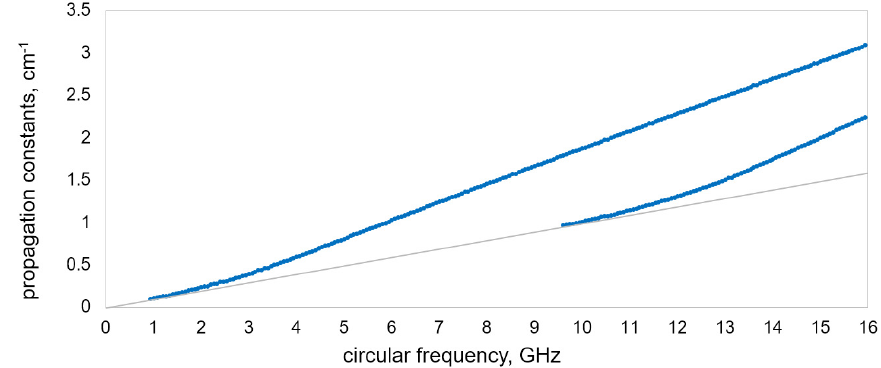
Figure 3: Dispersion curves for the values of the components of the tensor ^ (cid:22) : (cid:22) (cid:26) = 1 + (cid:26); (cid:22) z = 1; (cid:22) φ = 1 . The blue curves correspond to hybrid waves.